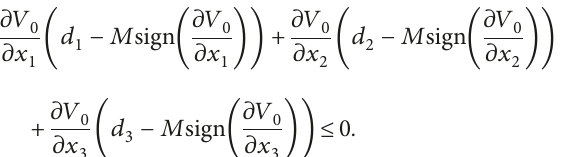
Figure 1: The chaos attractor of system (28) with